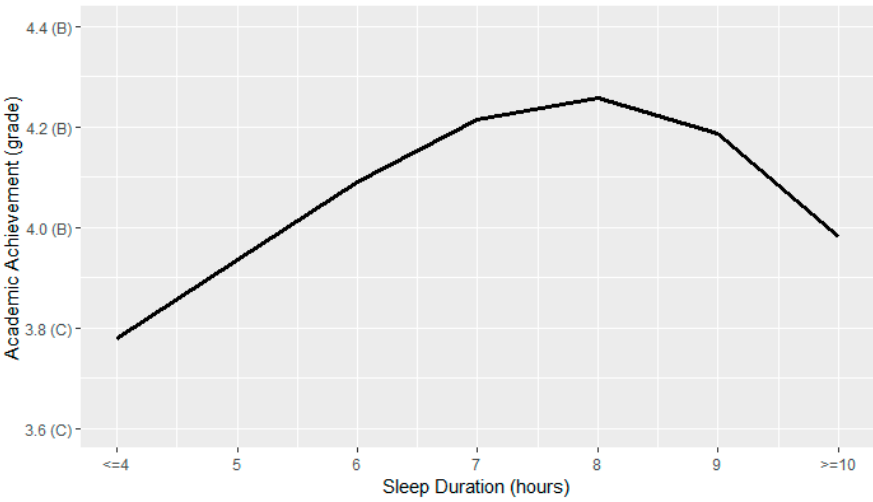
Figure 2 . Relationship between sleep duration and academic achievement. Figure 2. Relationship between sleep duration and academic achievement.